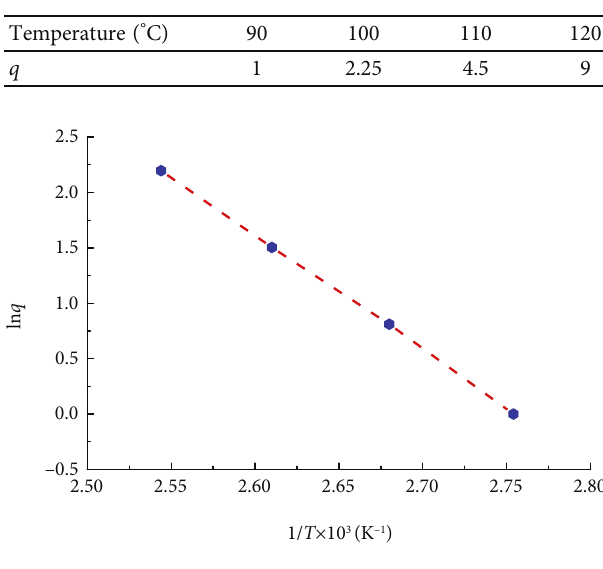
Figure 12: Regression and extrapolation results of the activation energy. Table 5: Parameters of Peck model.